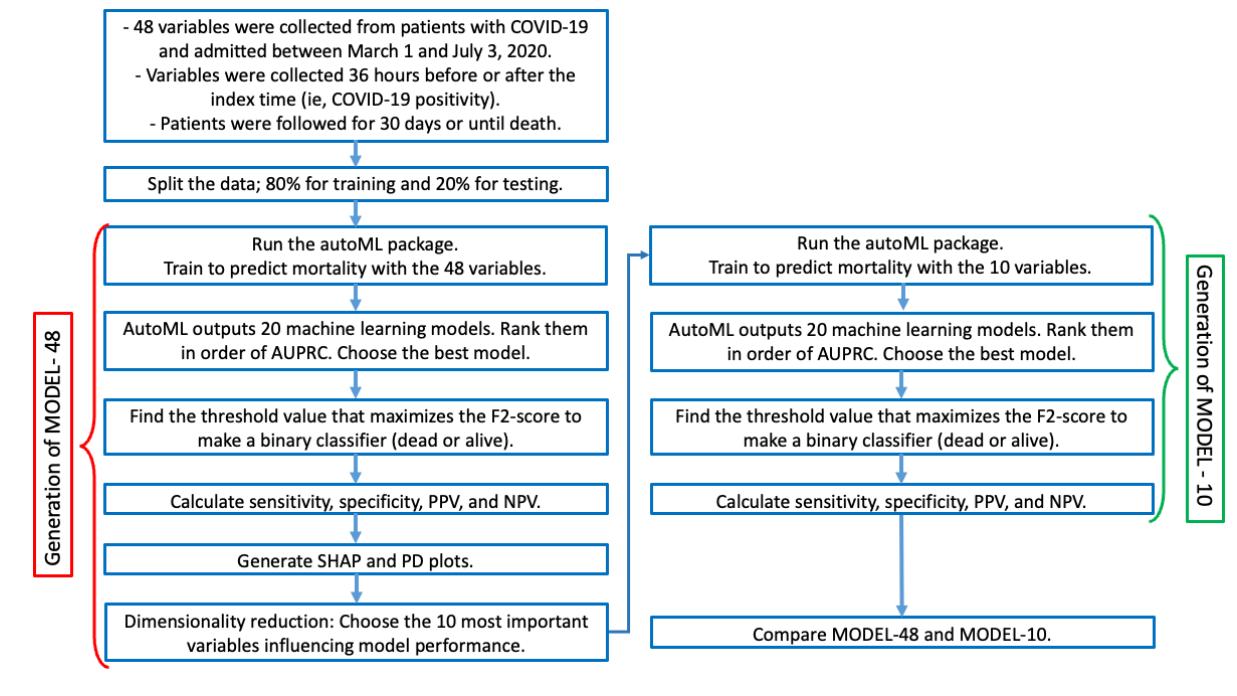
Figure 1. Flowchart summary of our methodology. AutoML: automated machine learning; AUPRC: area under the precision-recall curve; NPV: negative predictive value; PD: partial dependence; PPV: positive predictive value; SHAP: Shapley additive